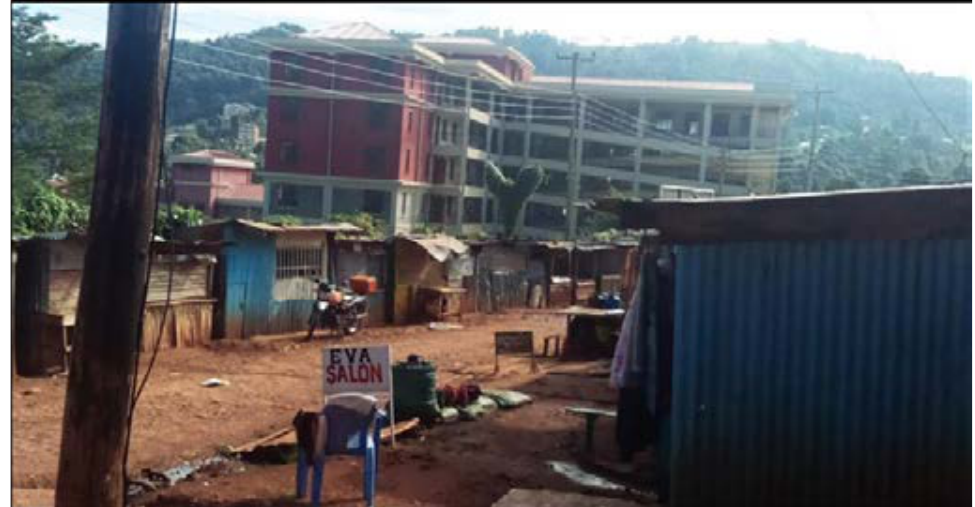
Fig. 9: Illegal developments behind the university’s newly constructed tuition block